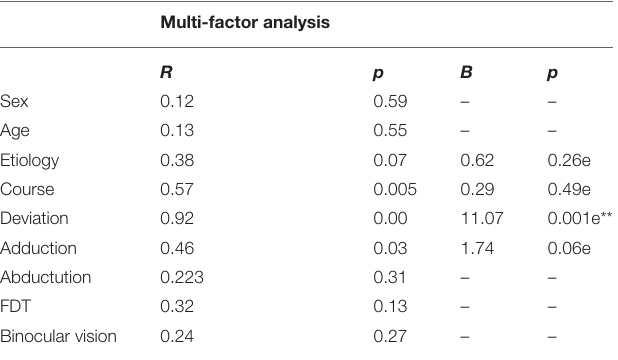
TABLE 6 | Factors associated with the dose-effect relationship of ultra R-R surgery.